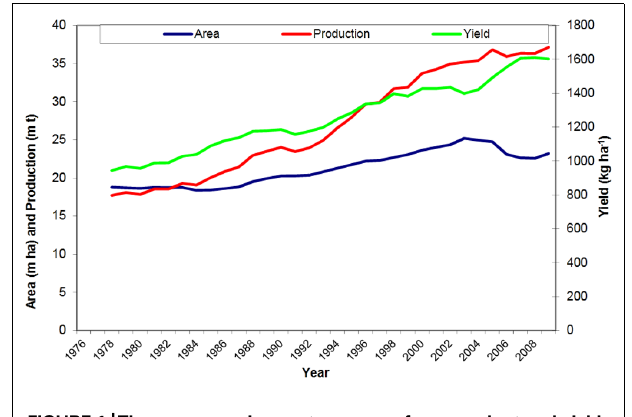
FIGURE 1 |Three-year moving center average for groundnut pod yield, production, and area harvested in